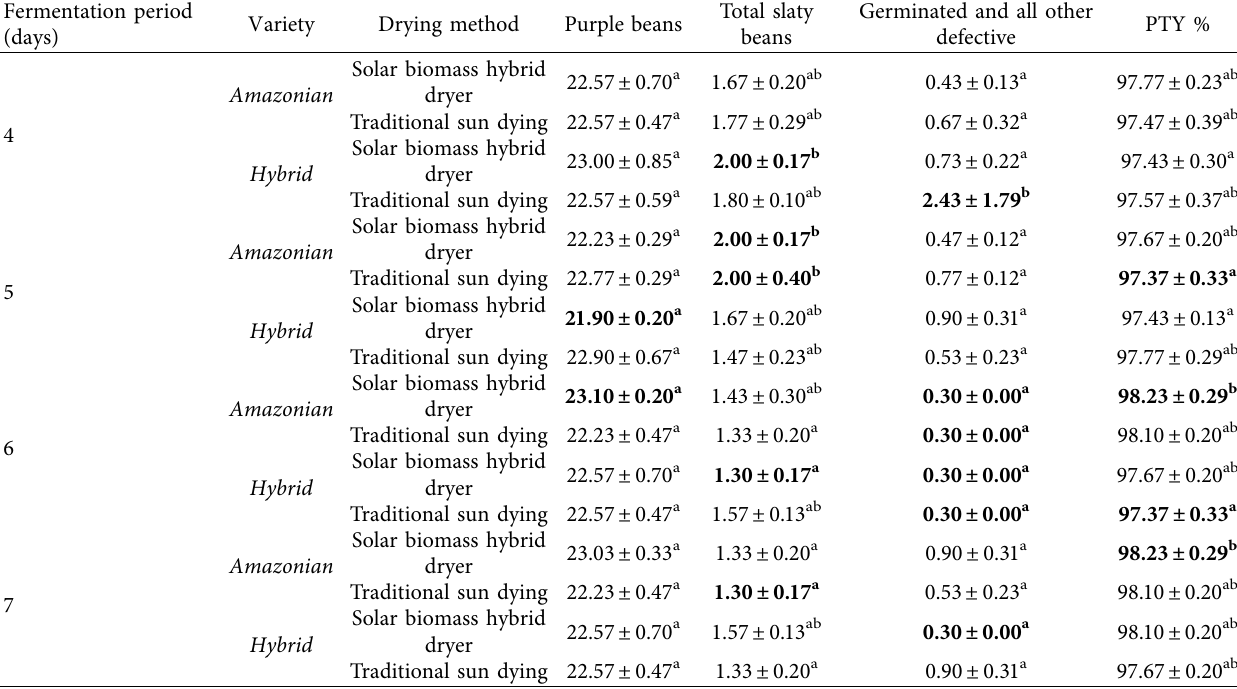
Table 4: Cut test properties of cocoa bean varieties under different fermentation and drying periods. Fermentation